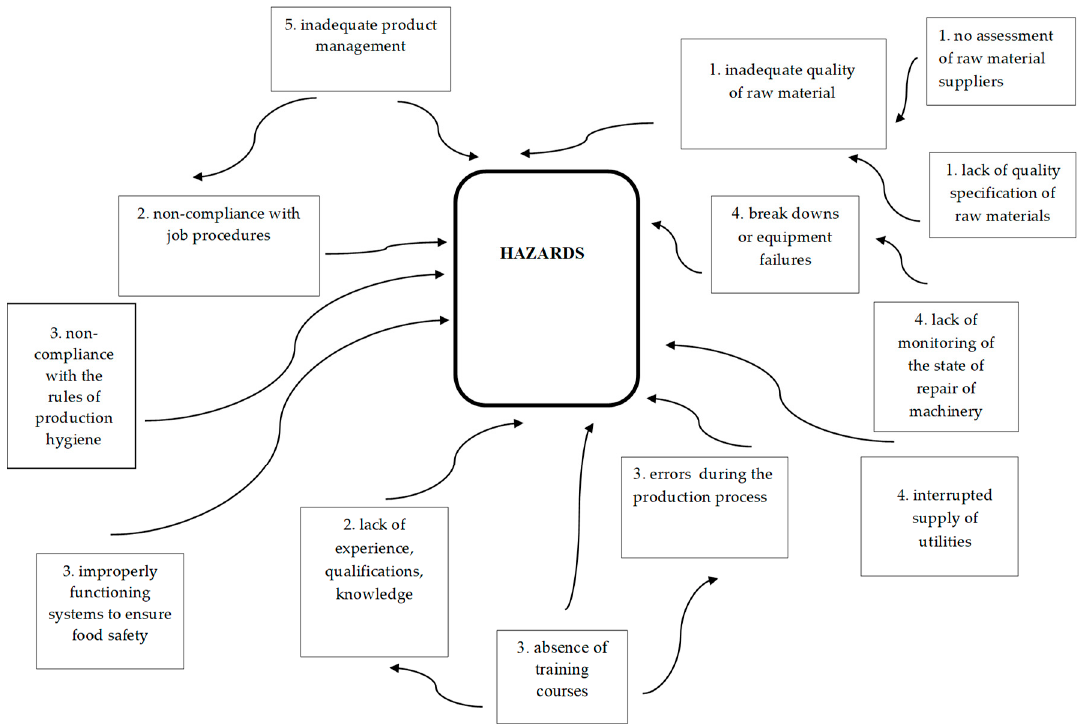
Figure 1. Relationship diagram illustrating the causes of hazards.